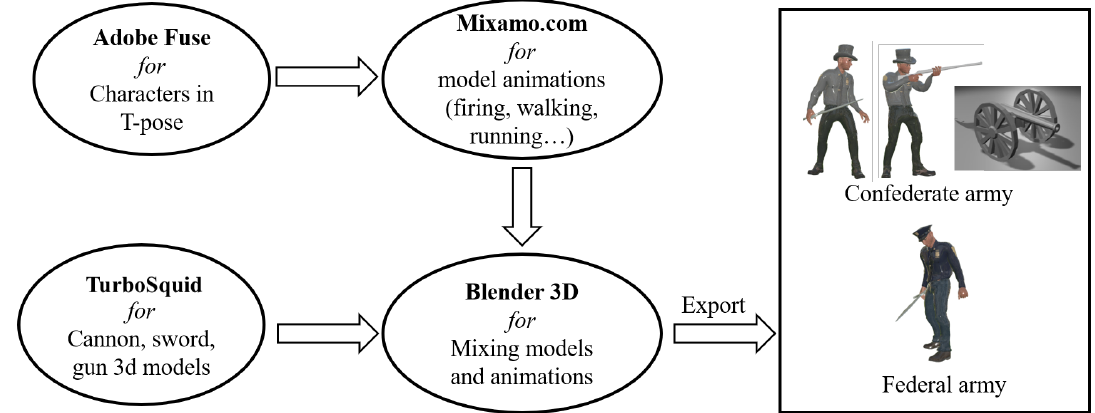
Figure 2. Converting free 3D models into web AR binary 3D